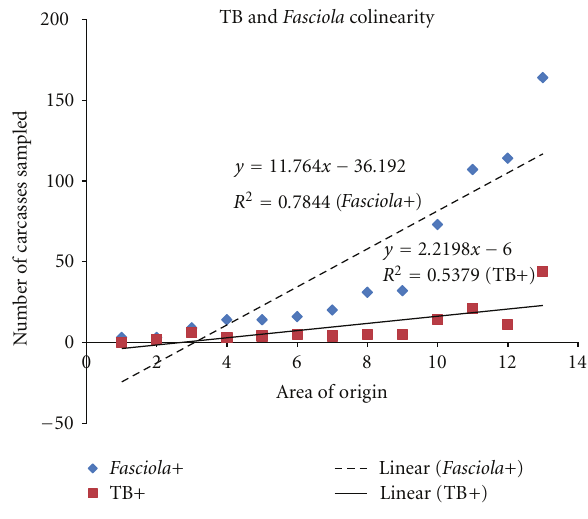
Figure 1: Map showing study